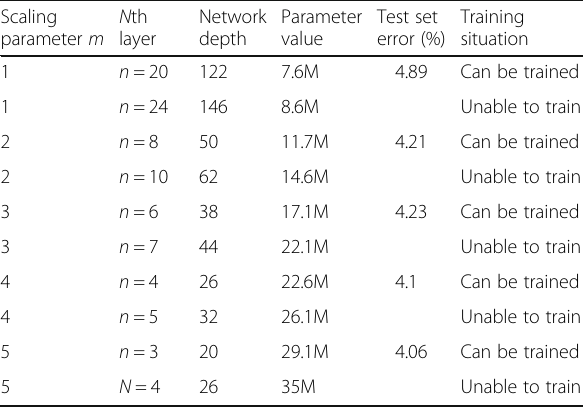
Table 1 Model operation under different scaling parameters and depths